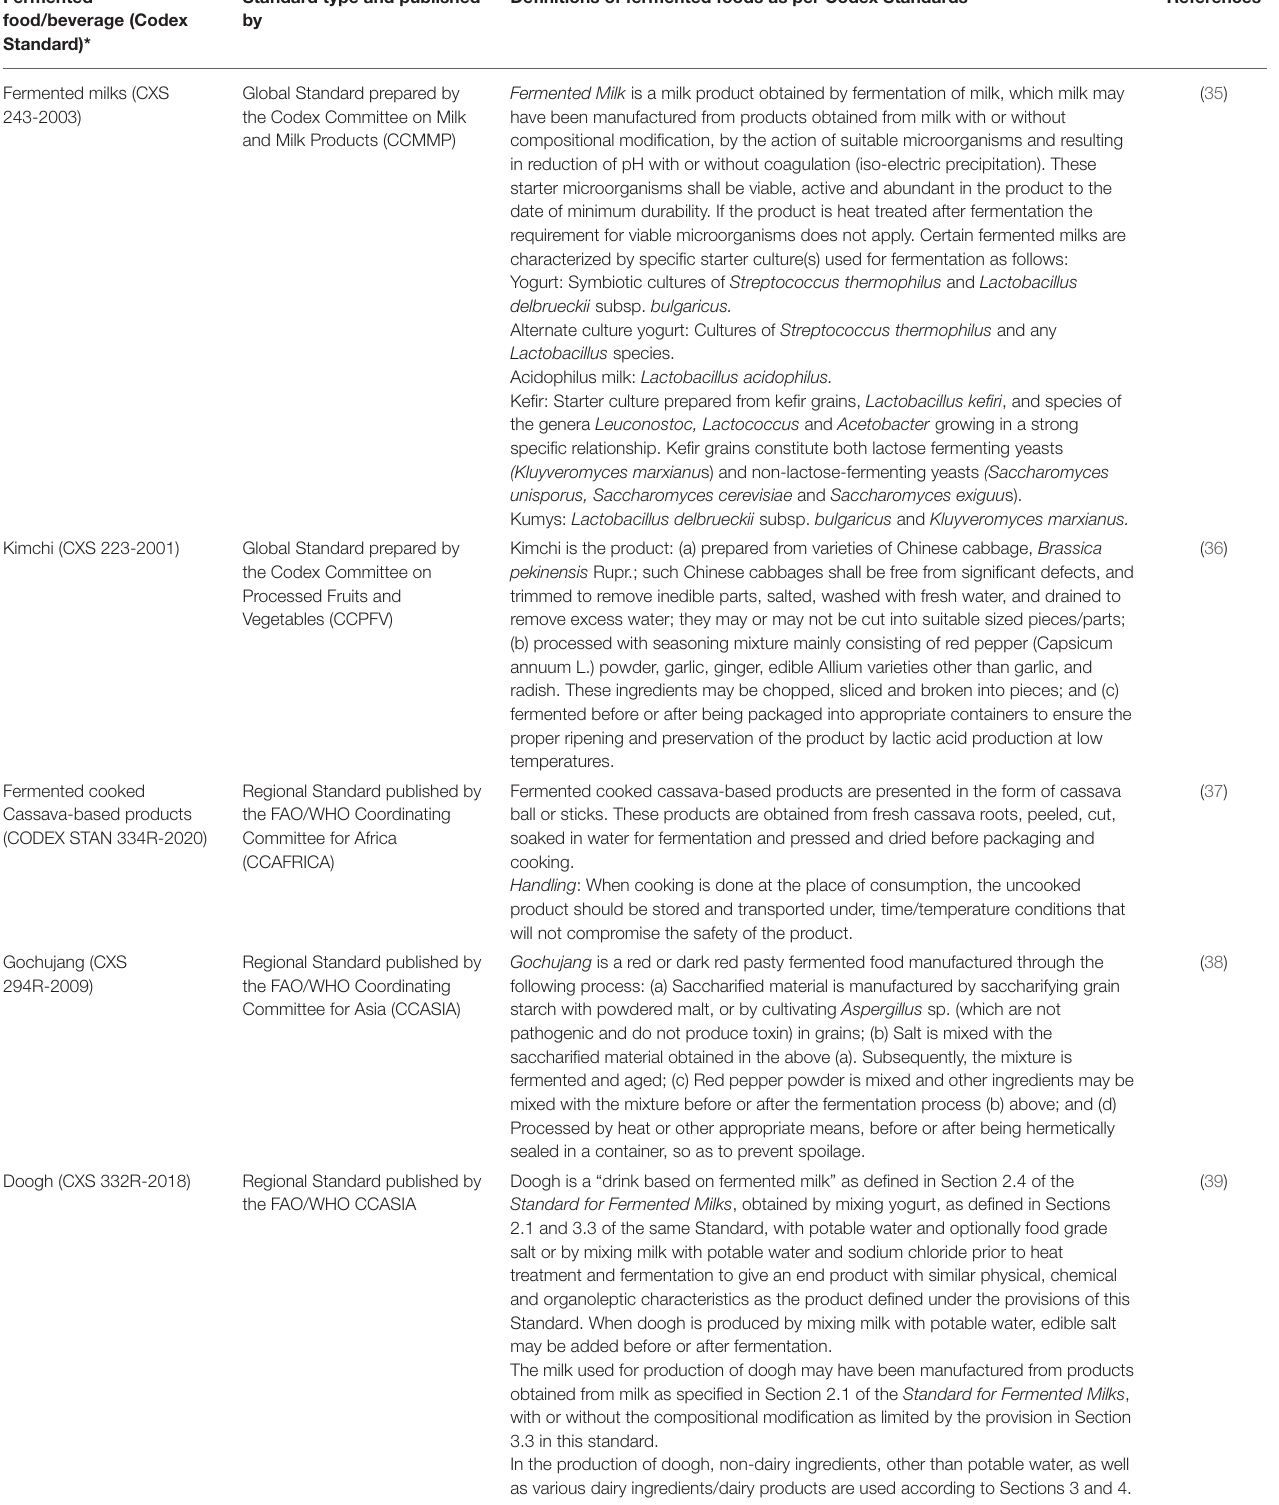
TABLE 1 | Codex Alimentarius Standards for fermented foods and